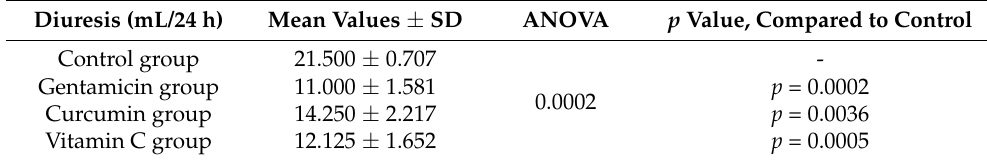
Table 2. Diuresis in our study groups.